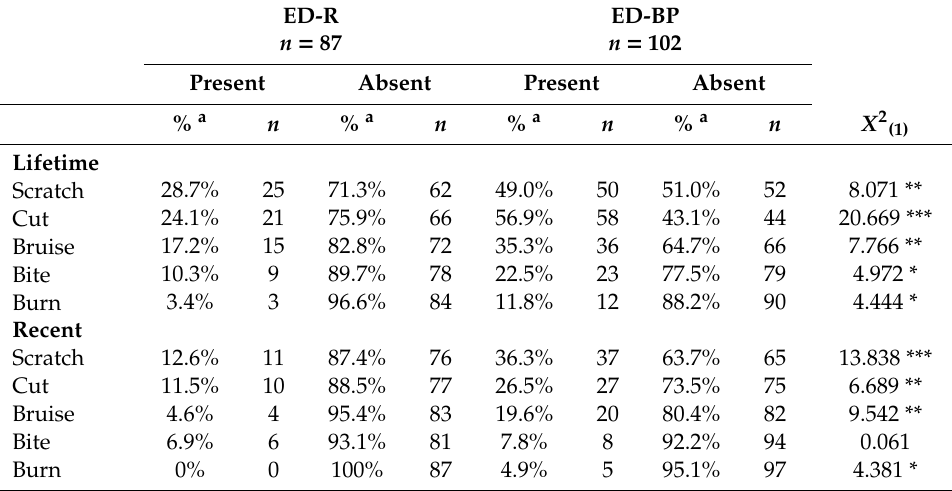
Table 2. Presence and absence of five NSSI behaviours in two ED subtypes.